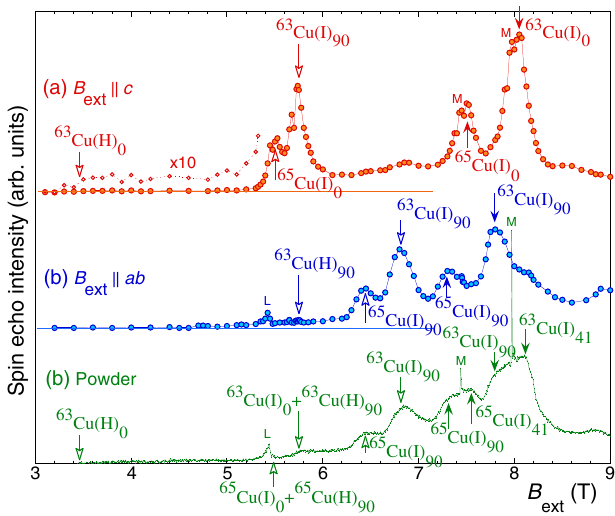
FIG. 15. Field sweep 63 ; 65 Cu NMR line shapes observed at 10 K at a fixed frequency of 90.307 MHz for (a),(b) a uniaxially aligned powder and (c) an unaligned powder. Key features associated with 63 Cu ( 65 Cu) isotope are marked with downward (upward) arrows. The subscripted numbers 0, 41, and 90 denote the angle θ between B and the crystal c axis. Filled and open ext arrows distinguish the features arising from the I z ¼ þ 1 = 2 to − 1 = 2 central transition and I 1 = 2 to (cid:3) 3 = 2 satellite tran- z ¼ (cid:3) sition. Peaks designated with the letter M (or L ) are background signals from 63 Cu and 65 Cu metal parts (or 7 Li) in the sample environment.